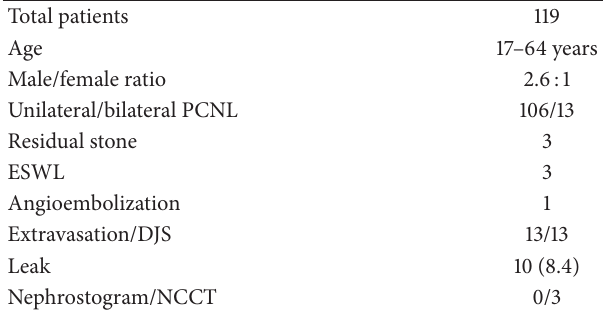
Table 1: Clinical profile of the patients (total